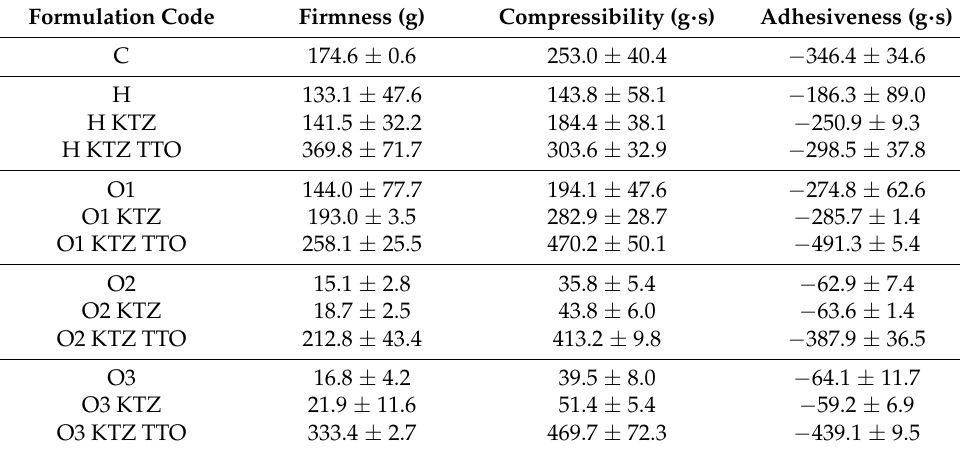
Table 4. Textural properties of prepared PLU ® F-127 hydrogels and PLO organogels containing KTZ (H KTZ, O1 KTZ, O2 KTZ, O3 KTZ), KTZ and TTO (H KTZ TTO, O1 KTZ TTO, O2 KTZ TTO, O3 KTZ TTO), placebo gels (H, O1–O3), and commercially available product (C). Values are expressed as means ± SD of six